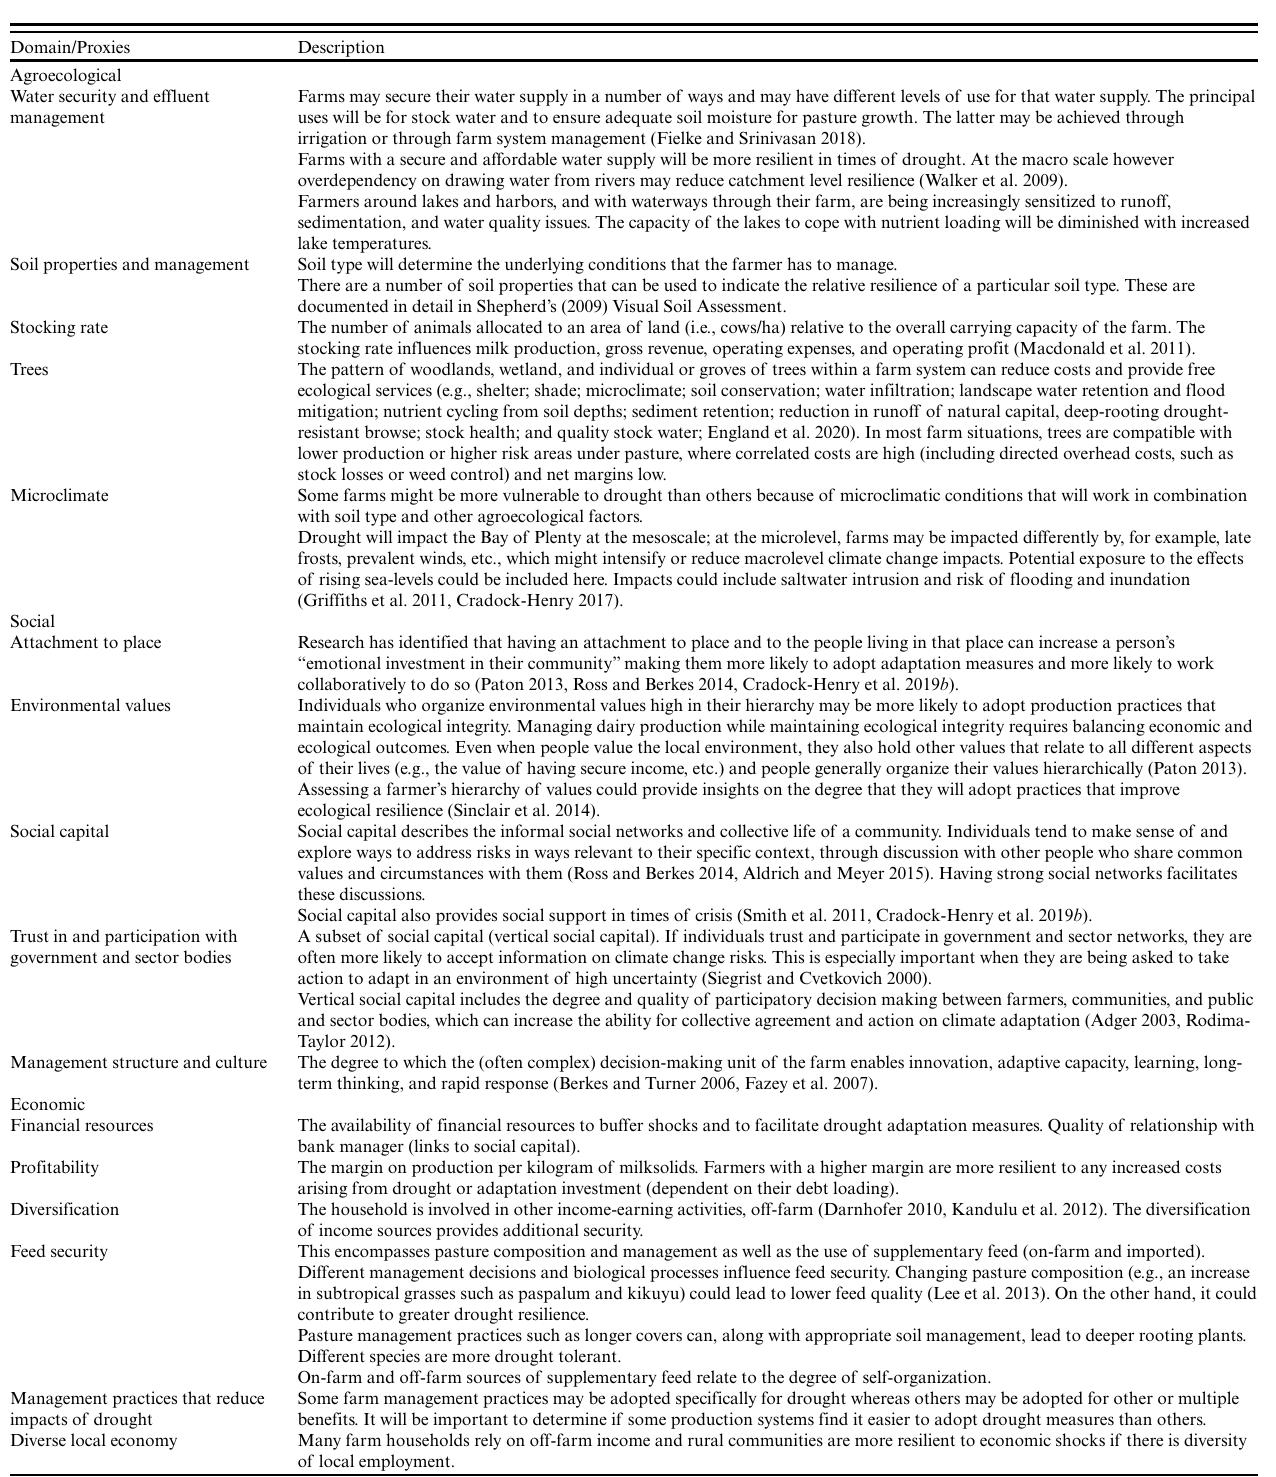
Table 3 . Characteristics of farm-level